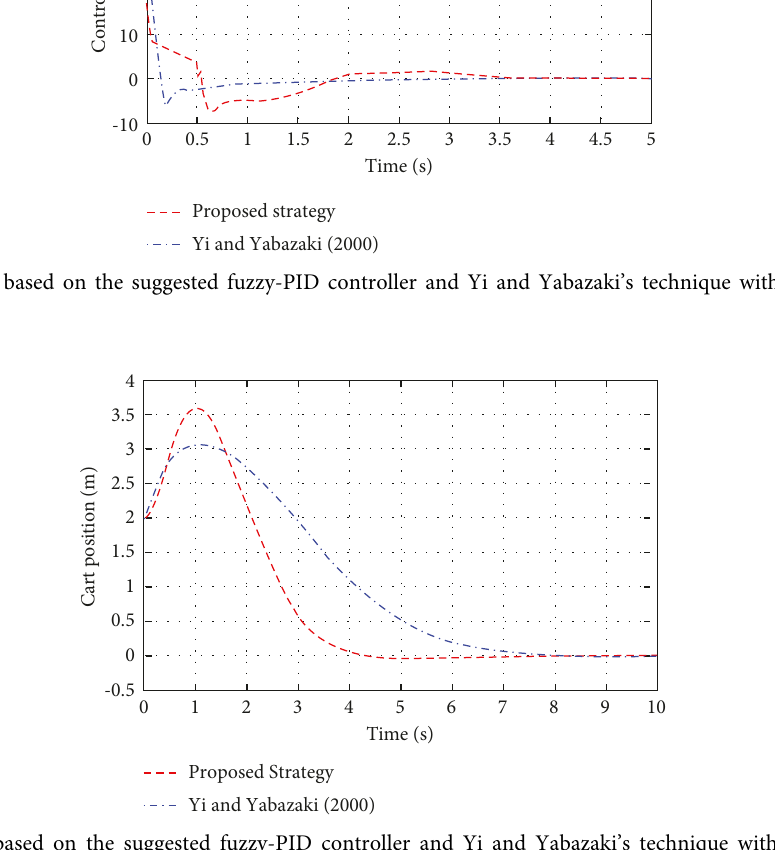
Figure 13: Cart position based on the suggested fuzzy-PID controller and Yi and Yabazaki’s technique with [ 0 , 2 , 0 , 0 , π /6 , 0 ] initial condition.